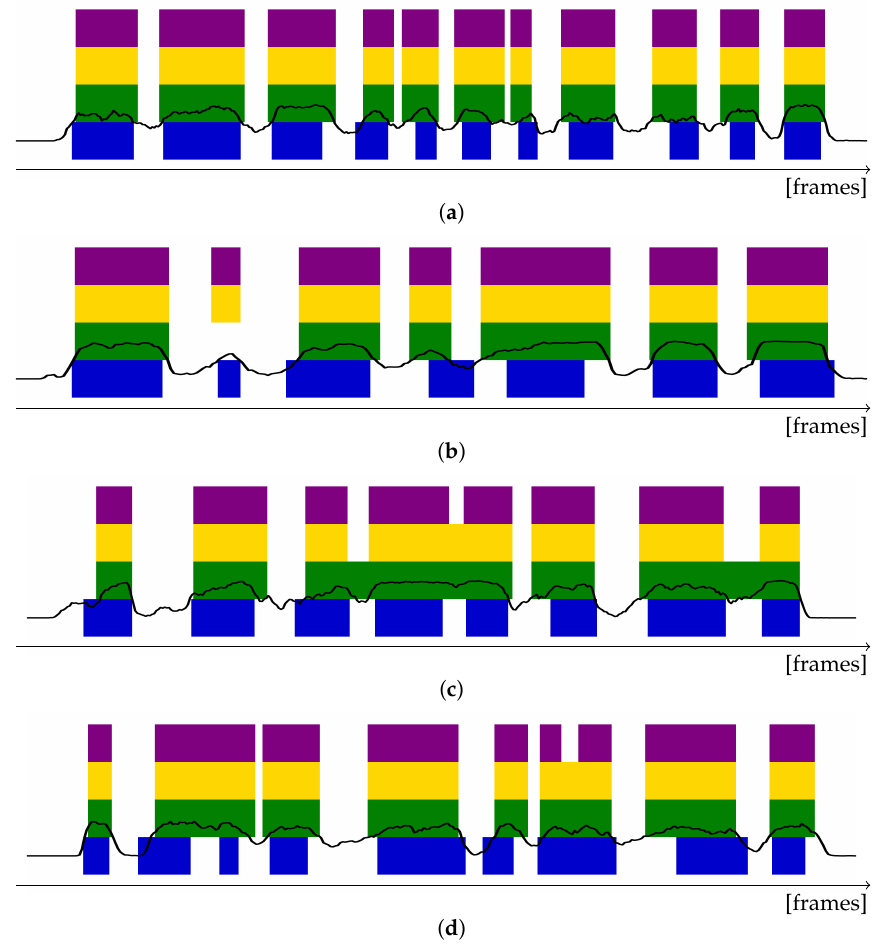
Figure 5. Sample segmentation results for 4 different sentences ( a – d ). Blue: Ground truth segments. Black: Confidence curves c of the automatic segmentation without smoothing. Green: segmentation sp smg obtained from strong Gaussian smoothing of sp ini . Yellow: sp med obtained from retrieving smoothed out local peaks. Purple: split proposal sp fin as used for final evaluation in this